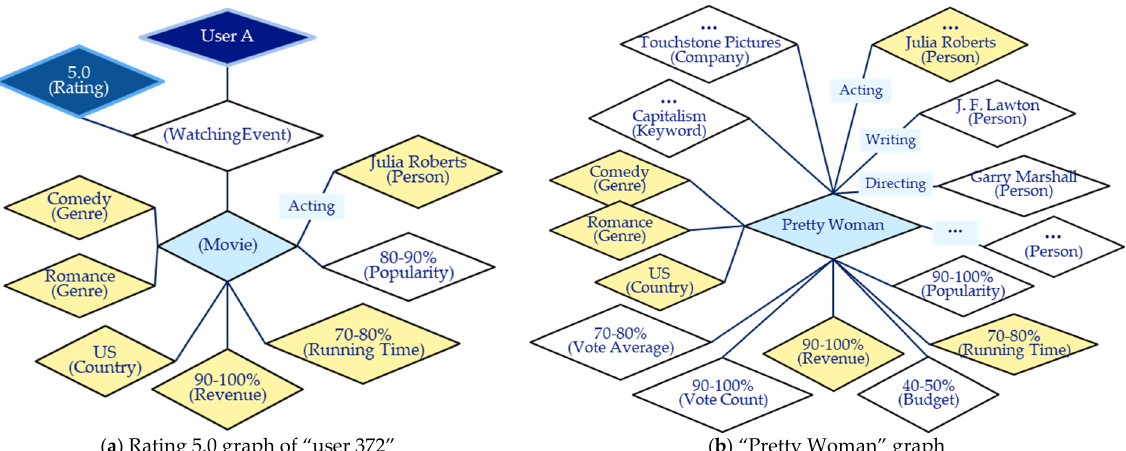
Figure 26. Example of rating graph and movie graph.